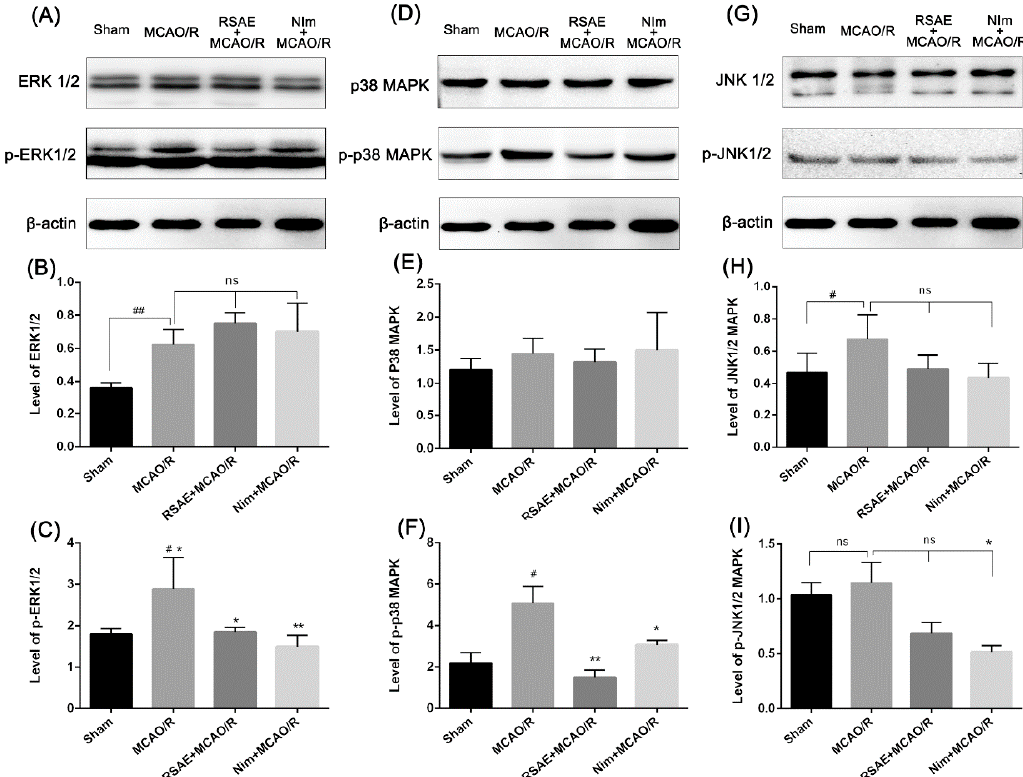
Figure 8. Effects of RSAE on the expression of phosphorylated ERK1/2, JNK1/2, and P38 in the hippocampus of ischemic brain sections. ( A , D , G ) The protein levels of phospho-ERK, phospho-P38, and phospho-JNK, respectively, in the hippocampus of ischemic brain sections were examined by western blot analysis. ( B , C , E , F , H , I ) The IOD values of ERK1/2, p-ERK, JNK1/2, p-JNK1/2, P38 and p-P38, respectively, were quantified and analysed using Gel-Pro analyzer software. Mean values ± standard error of the mean (n = 3); * p <0.05, ** p < 0.01, versus MCAO/R group; # p < 0.05, ## p < 0.01 versus sham-operated group; ns means not